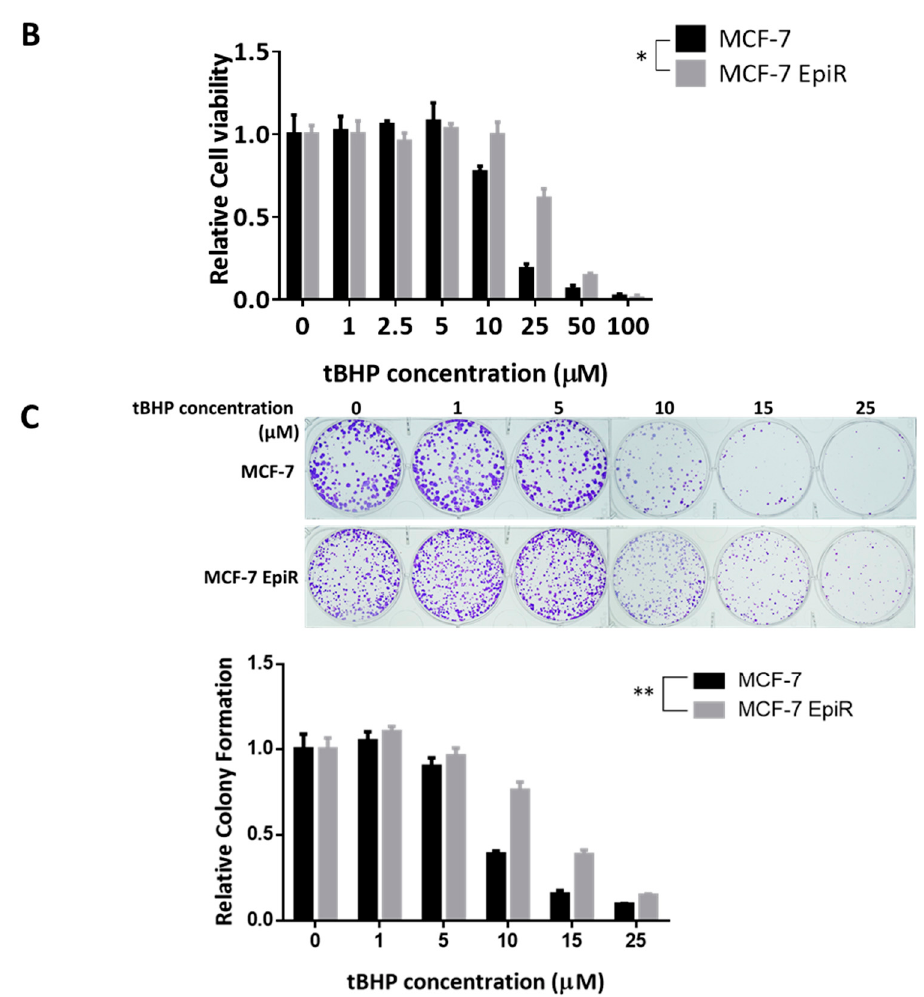
Figure 1. Epirubicin-resistant breast cells have enhanced capacity against oxidative stress. ( A ) Epirubicin-sensitive MCF-7 and Epirubicin-resistant MCF-7 EpiR cells were treated with 25 µM of oxidative stress inducer tert-Butyl hydroperoxide (tBHP) for 24 h. Epirubicin-sensitive MCF-7 and Epirubicin-resistant MCF-7 EpiR cells were stained with CellROX Deep Red reagent and analyzed for ROS levels using flow cytometry. Data were analyzed by FlowJo software. The mean fluorescence values were presented as relative ROS level compared to untreated cells (0 µ M). Data presented as means ± SD and Student’s t -test was used to compare the means: * p < 0.05; ** p < 0.01; *** p < 0.001; n.s. nonsignificant. (N = 3) ( B ) SRB assay was used to analyze the cell viability of MCF-7 EpiR cells treated with tBHP as compared to MCF-7 cells. Relative cell viability under di ff erent concentrations of tBHP treated for 72 h as compared with untreated cells. Data was presented as means ± SD and analyzed by two-way ANOVA and found to be significantly di ff erent between MCF-7 and MCF-7 EpiR cells, * p < 0.05. (N = 3) ( C ) MCF-7 and MCF-7 EpiR cells were treated with increasing concentrations of tBHP, and their sensitivity to tBHP was assessed by clonogenic assay. Their clonogenicity in response to tBHP was analyzed by two-way ANOVA and found to be significantly di ff erent (** p < 0.01) from one another (N = 3).